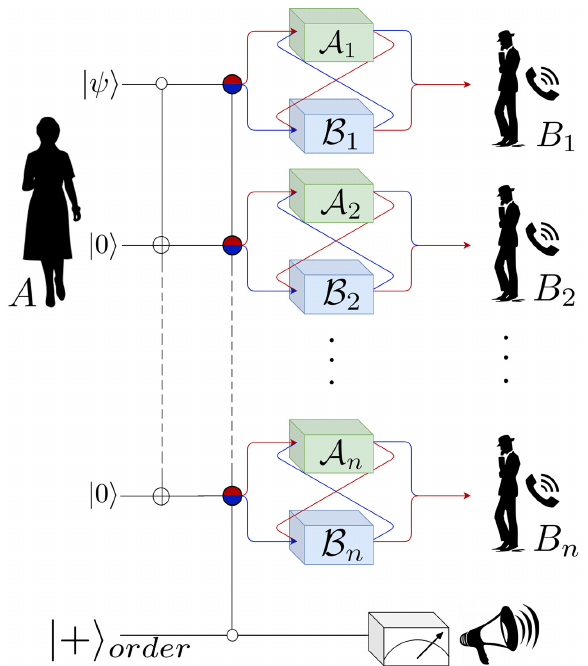
FIG. 2. Random-receiver quantum communication through noisy channels. Perfect protocol with entanglement-breaking channels in a superposition of orders. Alice encodes the unknown qubit state ψ in an n -partite GHZ state and sends it through the noisy channels. An order qubit controls the order in which